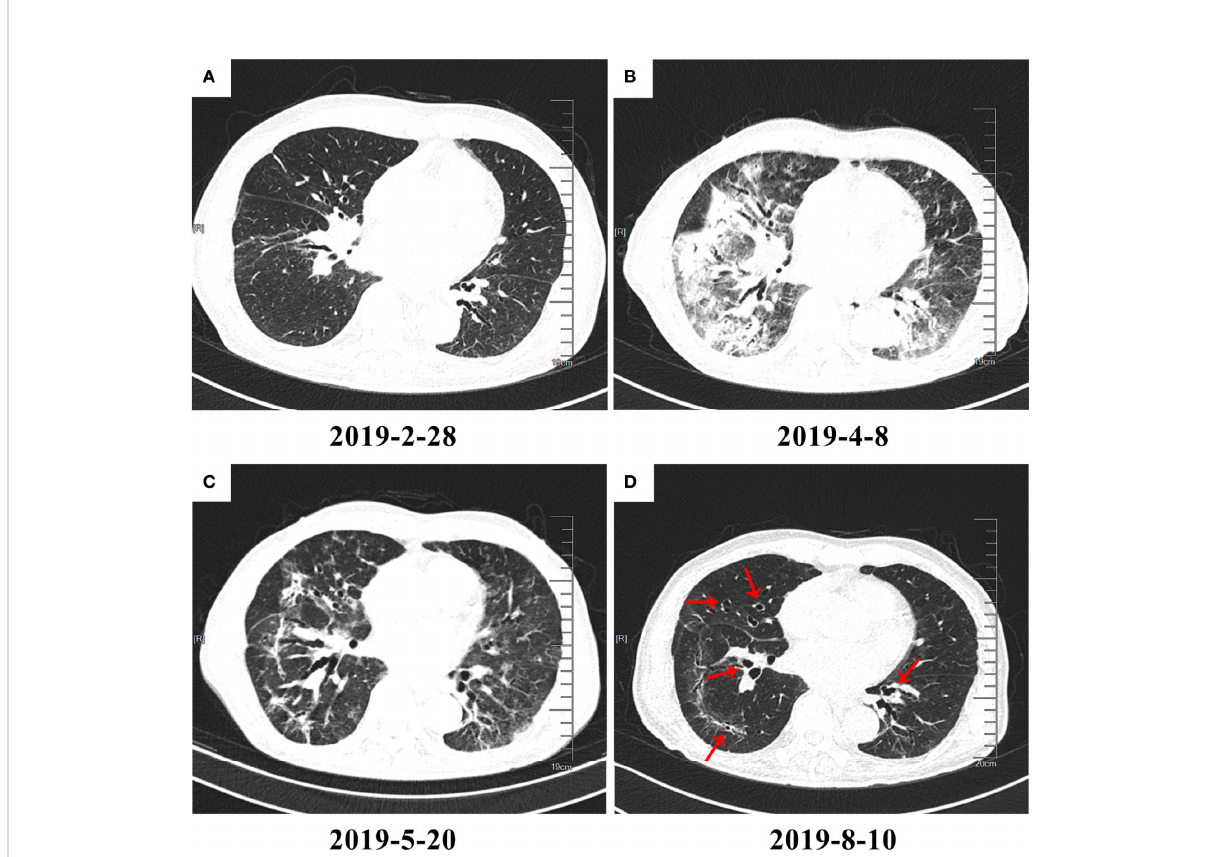
FIGURE 2 High-resolution computed tomography (HRCT) imaging of checkpoint inhibitor – related pneumonitis (CIP) in different phases. On March 1, 2019, the patient began immunotherapy and developed CIP on April 8, 2019. (A) Baseline HRCT image. (B) CIP in the acute phase. Diffuse patchy shadows and ground-glass opacities (GGOs) with consolidation can be seen in the image. (C) CIP in the subacute phase. The patchy shadows, GGOs, and consolidation appear to have been greatly absorbed. However, traction bronchiectasis can be seen developing to a severe degree. (D) CIP in the chronic phase. Most in fl ammation-related changes have been absorbed, and the lesions are mainly leftover traction bronchiectasis (red